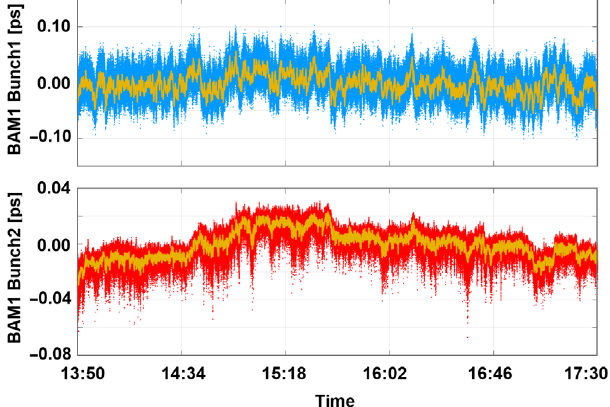
FIG. 11. First bunch (upper plot) and second bunch (lower plot) arrival times at 100 Hz repetition rate measured by the BAM at the laser heater, downstream of the photocathode gun at Z ¼ 13 m.